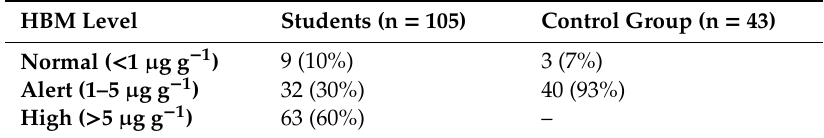
Table 3. Threshold limit by human bio monitoring commission of the German Federal Environment